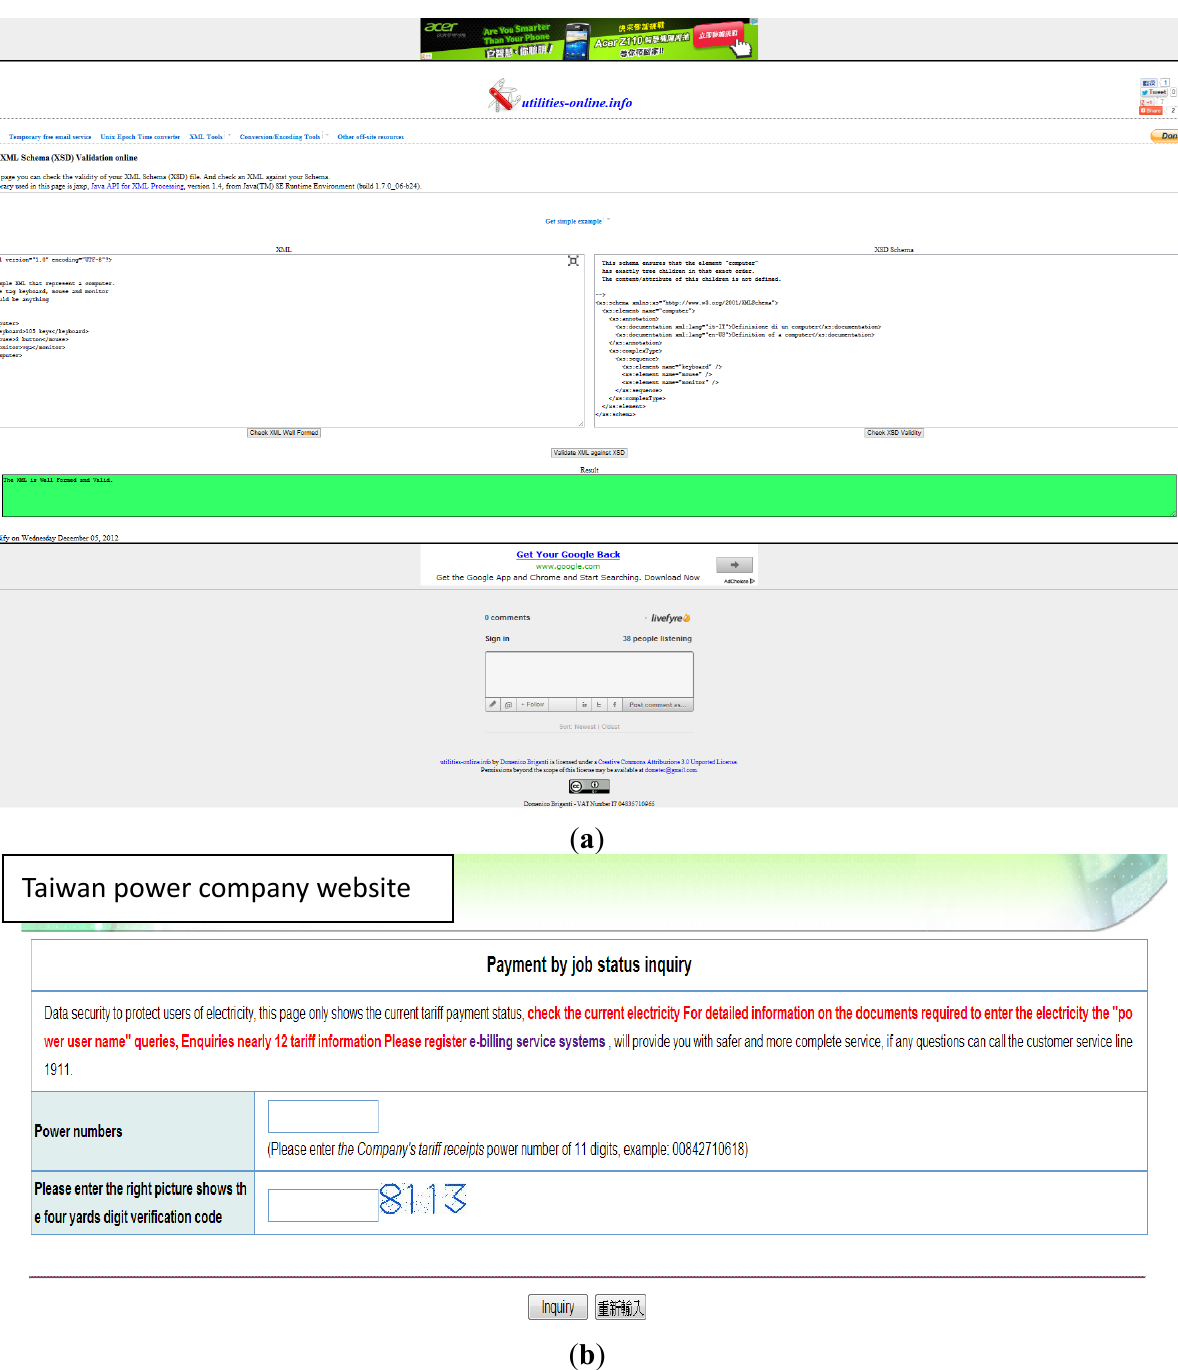
Figure 2. Pre-defined URL list includes: ( a ) XML program for chain store check as the first algorithm of data array analyzer; ( b ) Public website of Taiwan power company for querying energy usage of the store; ( c ) Public website of economic bureau for surveying company capital of the store; ( d ) Public website of ministry of interior for querying house price of the store; ( e ) Google website for surveying how many web pages related to the store; ( f ) Combining Google map and weather condition database, XML program can be used to estimate weather influence on energy usage of the